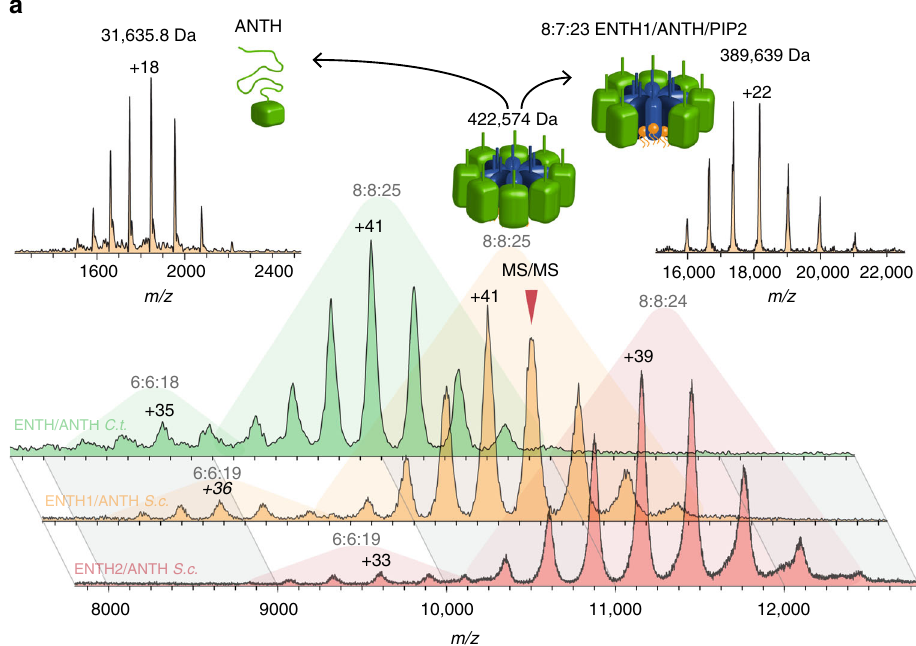
Fig. 4 ENTH/ANTH/PIP2 complex formation in fungi 6:6:~18 and 8:8:~24 ENTH/ANTH/PIP2 complexes are the observed stoichiometries in native MS measurements. A cartoon of the most prominent complex is shown with ANTH in green and ENTH in blue. Complexes from C. thermophilum (green) and S. cerevisiae , containing ENTH1 (orange) or ENTH2 (red), show the same stoichiometries, signal ratios and dissociation pathways in collision-induced dissociation (CID) MS/MS. Here, the dissociation of the +40 charged 8:8:25 ± 3 ENTH1/ANTH Sla2 /PIP2 complex into partially unfolded ANTH Sla2 (top left, cartoon shows green ANTH domain) and a residual 8:7:23 ± 1 complex (top right, showing also a cartoon of the remaining complex) is depicted. The annotation shows the stoichiometry (ENTH:ANTH:average PIP2 number), charge state of the main peaks, and average experimental masses. Ranges of PIP2 numbers, statistical errors, and an average FWHM value rating the MS resolution of all complexes can be found in Supplementary Table 2. ANTH dissociation in CID MS/MS measurements of 6:6:18 ± 1 ENTH2/ANTH Sla2 /PIP2 complexes from S. cerevisiae is presented in Supplementary Fig.